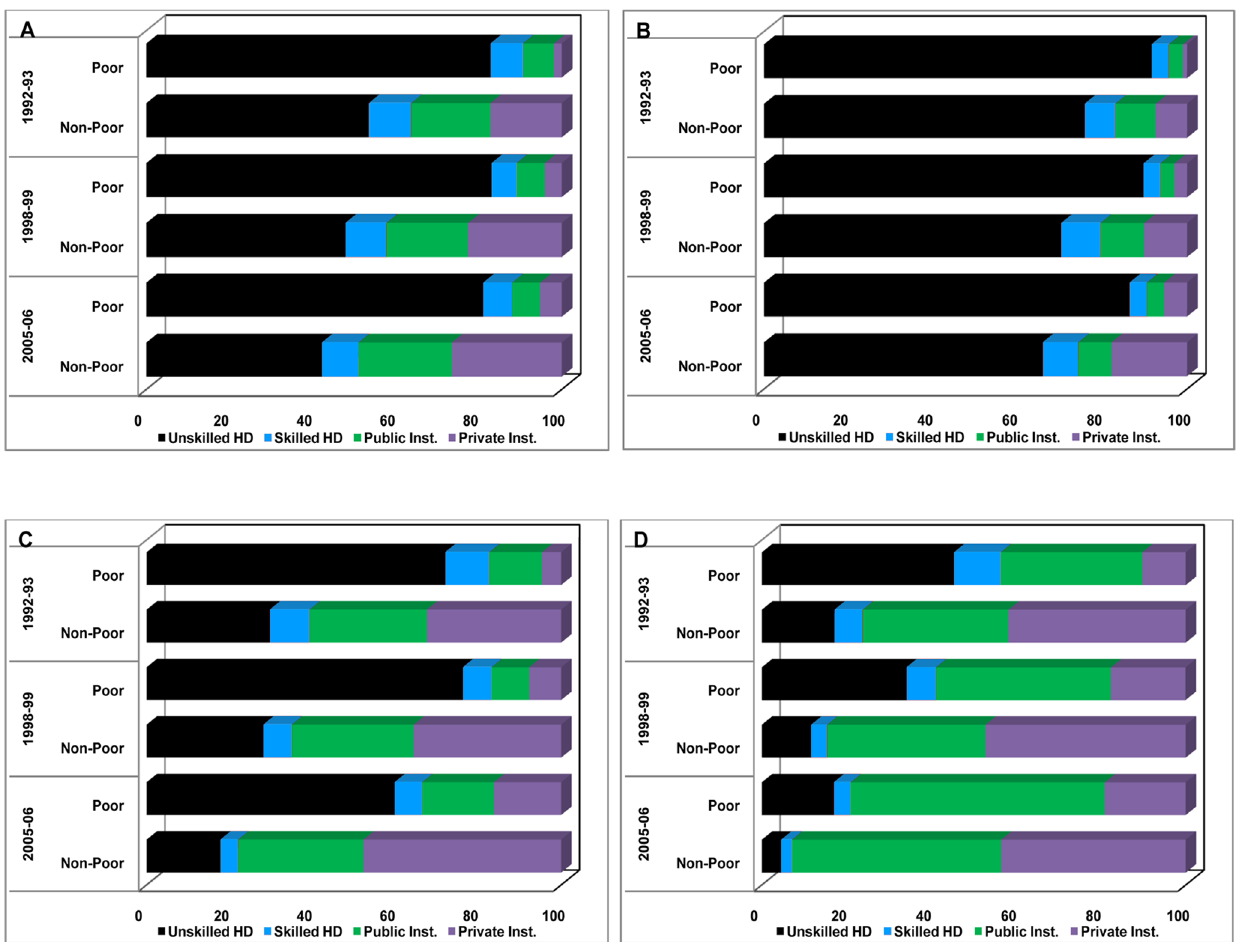
Figure 4. Percent distribution of births delivered by source of providers among poor and non-poor mothers across states, India, 1992–2006. X axis=Economic status [poor vs.non-poor] by survey year [1992–93; 1998–99; 2005–06]. Y axis=Type/place of birth attendance (in percent). Black bar=Unskilled delivery at home. Red bar=Skilled delivery at home. Green bar=Delivery at public health facilities. Purple bar=Delivery at private health facilities.